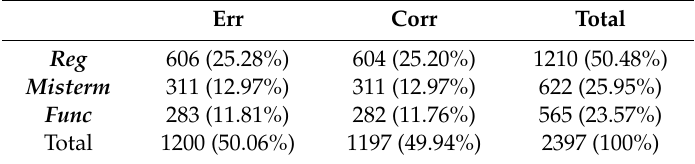
Table 7. Error counts and Error Type distribution of presented tokens: raw counts and percentages.